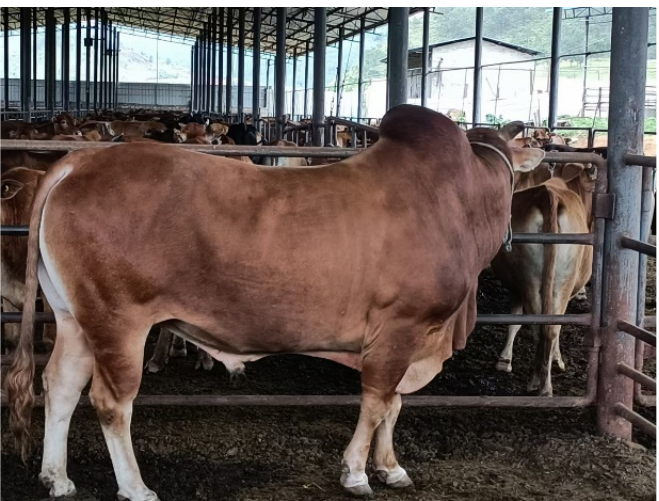
Figure 7. Example of herbivorous animal husbandry model (humped cattle basement). Models in Extremely Vulnerable